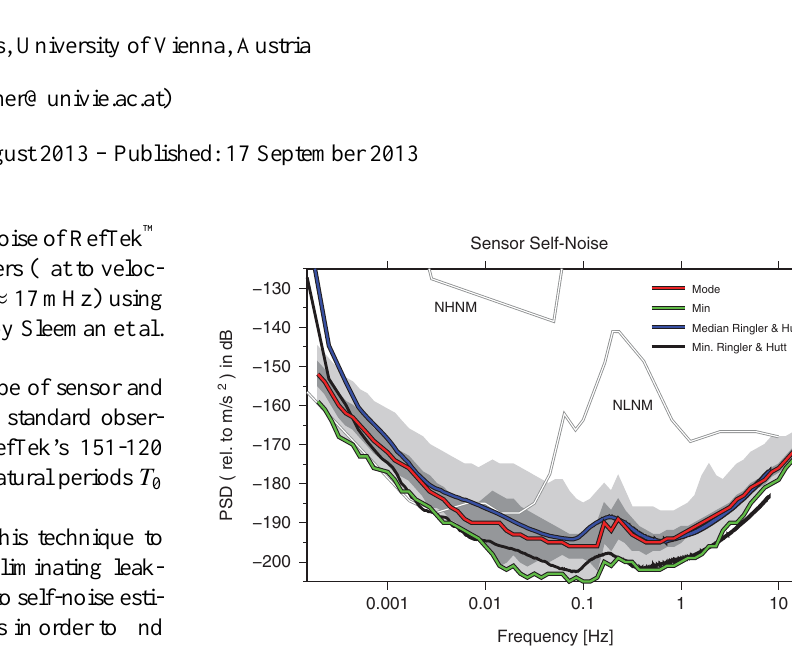
Fig. 1. Self-Noise model of the STS-2 as published by Sleeman and Melichar (2012). In all of the self-noise curves the signature of Earth’s microseisms, which are the dominant source of natural seismic background noise in the pictured frequency range (Peterson, 1993), can clearly be recognized (also see: Ringler and Hutt, 2010).